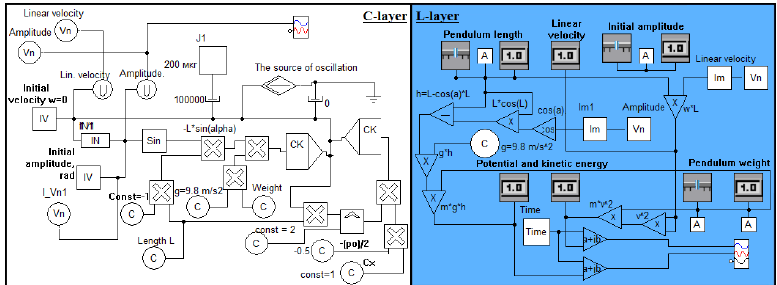
Fig. 7. Object and logical layers of the Physical Pendulum